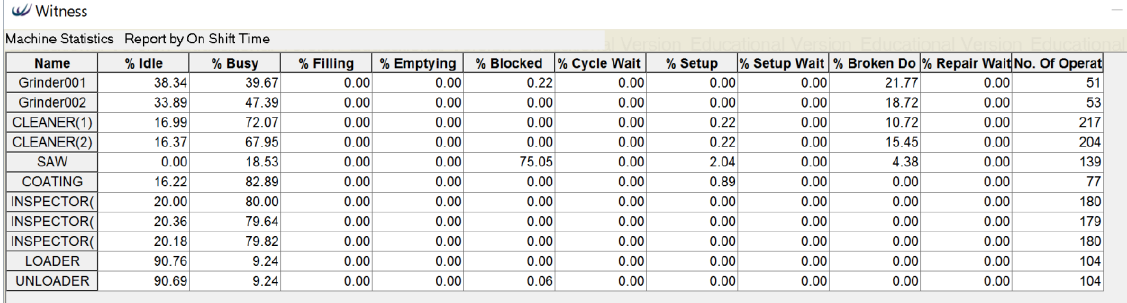
Figure15. Buffer statistics for shift time. Figure 15. Buffer statistics for shift